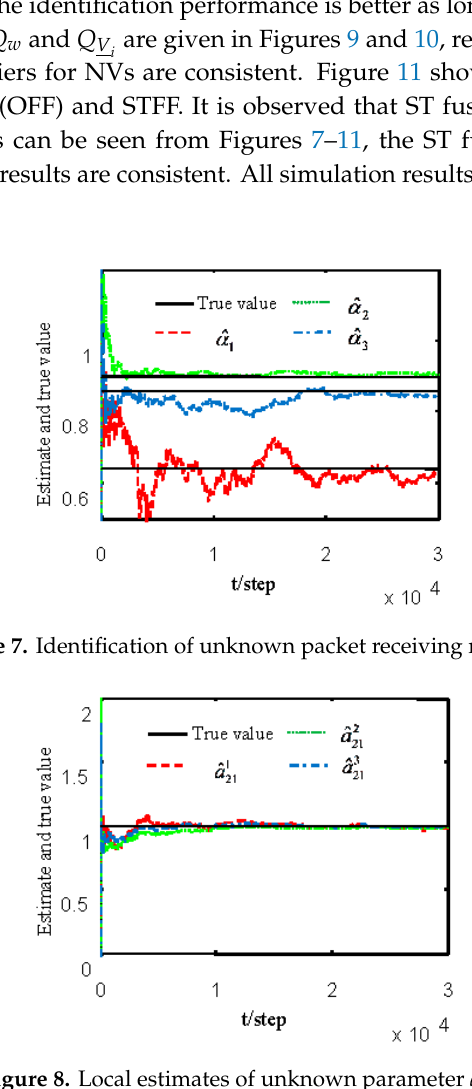
Figure 9. Identification of noise variance Figure 10. Identification of noise variances